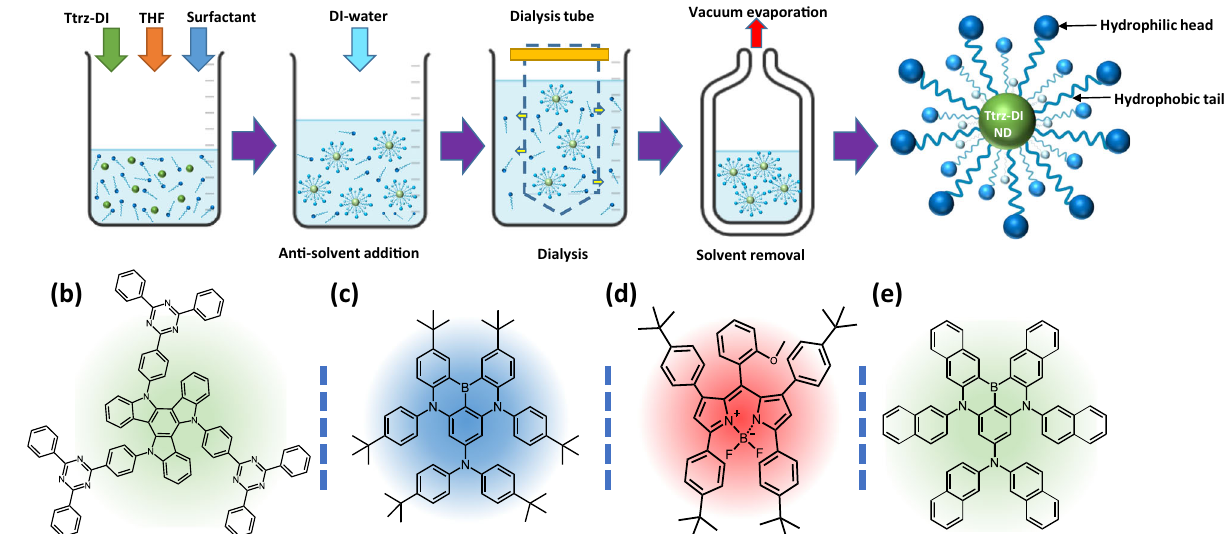
Fig. 1 Schematic diagrams. a Synthesis process of Ttrz-DI nano-dot dispersion using surfactants. Chemical structures of b Ttrz-DI, c CzDABNA, d 4tBuMB, e TNAP fl uorescent materials. b – e , the background color corresponds to the emission color of each fl